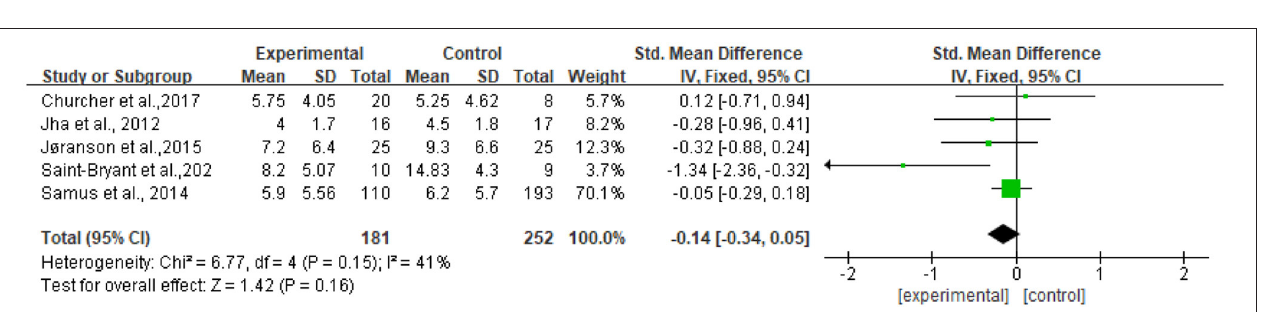
FIGURE 6 | Effect size of the intervention group vs. the control group on